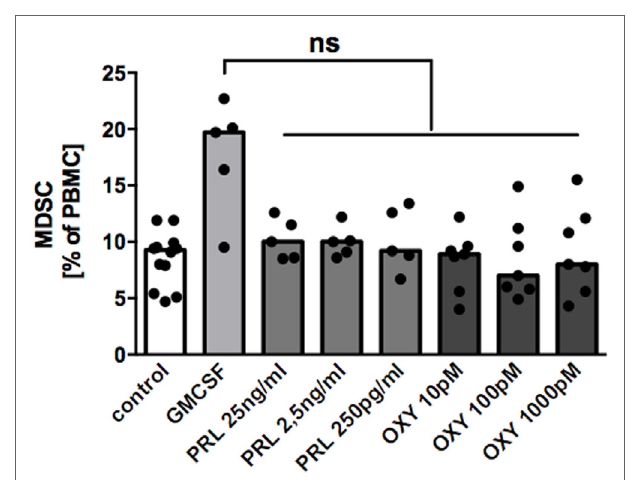
FigUre 5 | Effect of oxytocin and prolactin on induction of MDSC from peripheral blood mononuclear cell (PBMC). PBMC from healthy non-pregnant donors were cultured for 6 days either in medium only, in medium with 1 ng/ ml GM-CSF, or in medium with oxytocin (OXY) or prolactin (PRL) in indicated concentrations. After 6 days, cells were harvested and percentages of CD33 + cells analyzed by flow cytometry. Bar graph shows percentages of CD33 + MDSC after culture in medium alone (white bar), in medium with 1 ng/ml GM-CSF (light gray bar), or with oxytocin (OXY, medium gray bar) or prolactin (PRL, dark gray bar) in indicated concentrations. Bars represent pooled data from five to seven experiments and each point represents an individual sample. ns, not significant; Friedmann test and Dunn’s multiple comparison